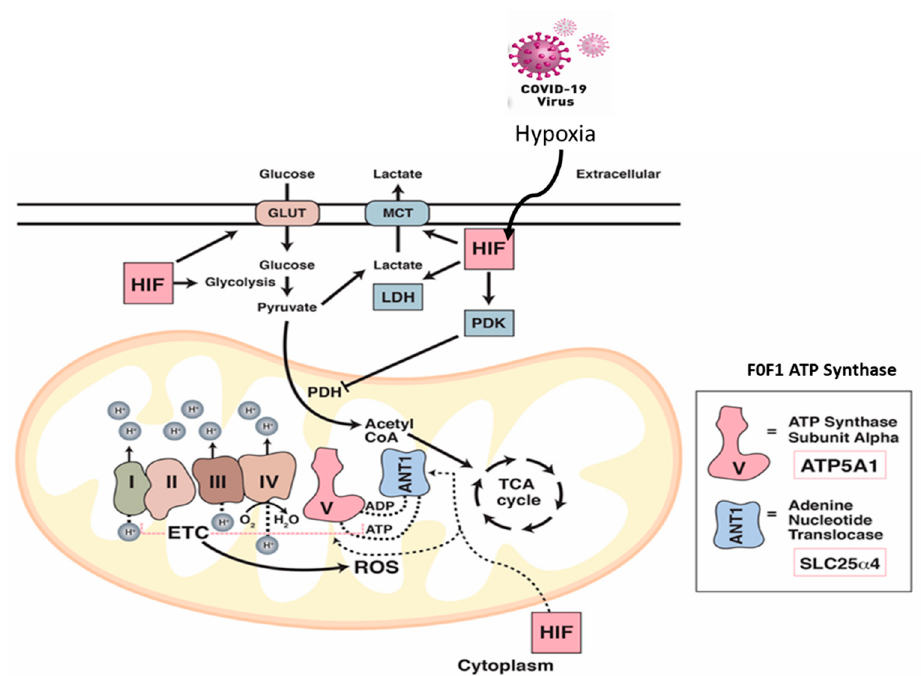
Figure 8. The impact of COVID-19 infection on oxygen homeostasis. Under normal aerobic conditions, HIF-1 regulates glucose metabolism resulting in pyruvate formation. Pyruvate dehydrogenase (PDH) converts pyruvate to acetyl-CoA for the entry into the TCA cycle. Under hypoxic and/or COVID-19 infection conditions, HIF-1 targets and activates many glycolytic enzymes including lactate dehydrogenase (LDH) to increase lactate production. HIF-1 also promotes pyruvate dehydrogenase kinase (PDK) to inactivate PDH which prohibits the conversion of pyruvate to acetyl-CoA. Under these infection conditions, the ETC becomes a source for reactive oxygen species (ROS) which stabilize HIF-1. Impairment of the ETC leads to significant depletion in the levels of ATP synthase subunit alpha (Atp5a1) responsible for producing ATP through mitochondrial complex V, and the ADP/ATP translocase (Slc25a4). Both proteins are regulated via HIF-1 α .